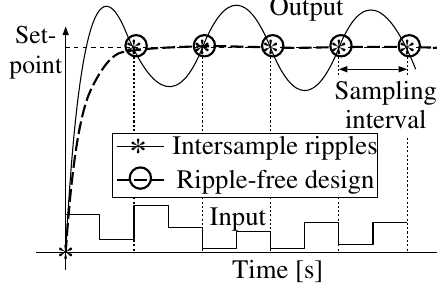
Figure 2. Trajectories with and without